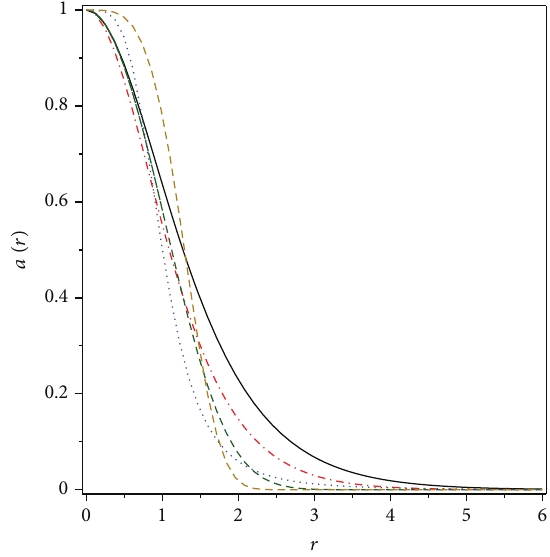
Figure 2: Solutions to 𝑎(𝑟) . Conventions as in Figure